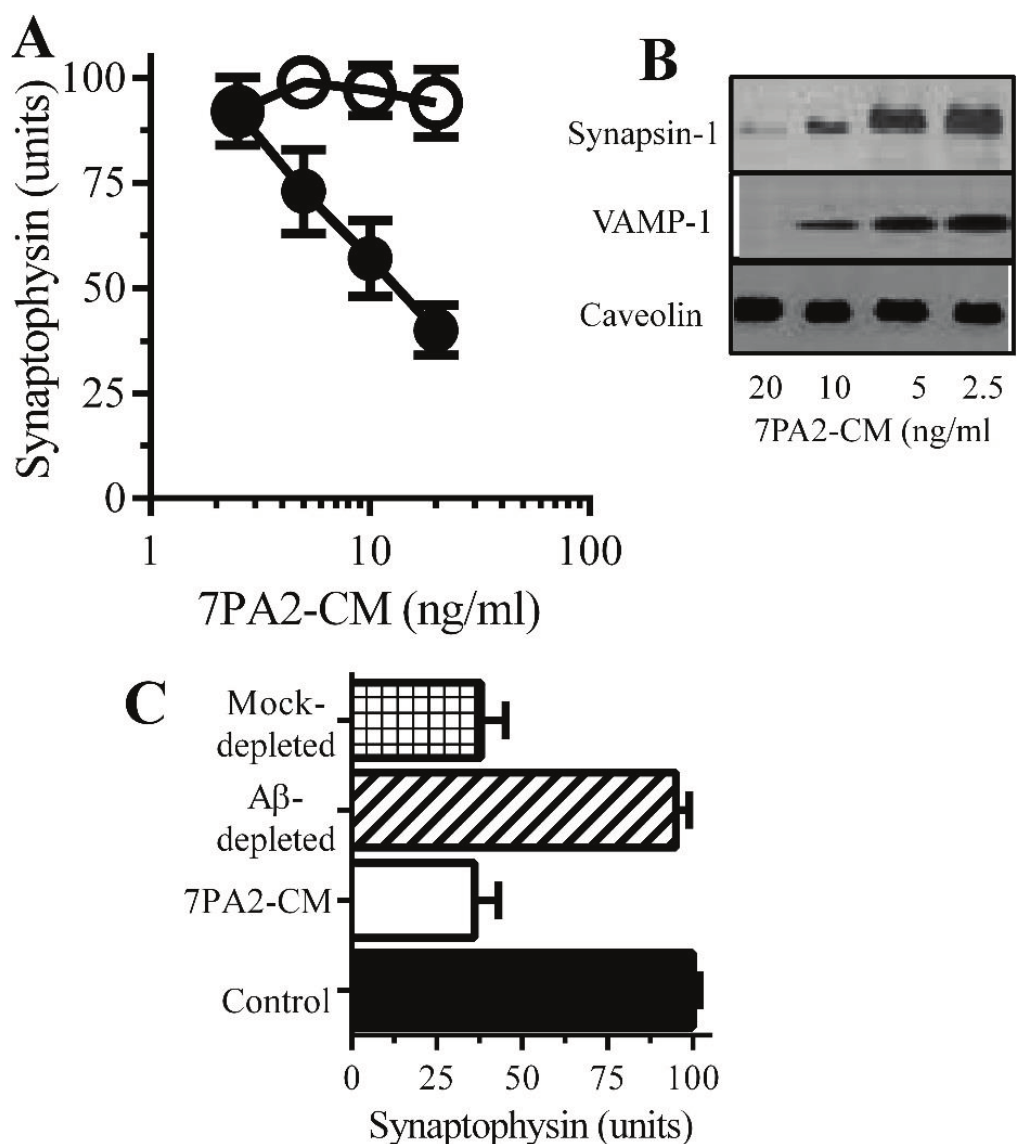
Figure 3. Aβ oligomers cause synapse damage in neurons : ( A ) The amounts of synaptophysin in cultured neurons incubated with 7PA2- CM (●) or CHO - CM (○) for 24 h. Values are means ± SD from triplicate experiments performed 4 times ( n = 12). ( B ) Immunoblots showing the amount of synapsin-1, VAMP-1 and caveolin in neurons incubated with 7PA2-CM for 24 h. ( C ) The amounts of synaptophysin in neurons incubated with control medium (■), 7PA2- CM (□), Aβ -depleted 7PA2-CM (striped bar) or mock-depleted 7PA2-CM (hatched bar) for 24 h. Values are means ± SD from triplicate experiments performed four times ( n =